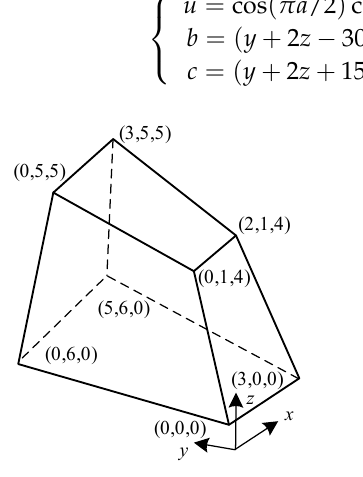
Figure 9. Irregular